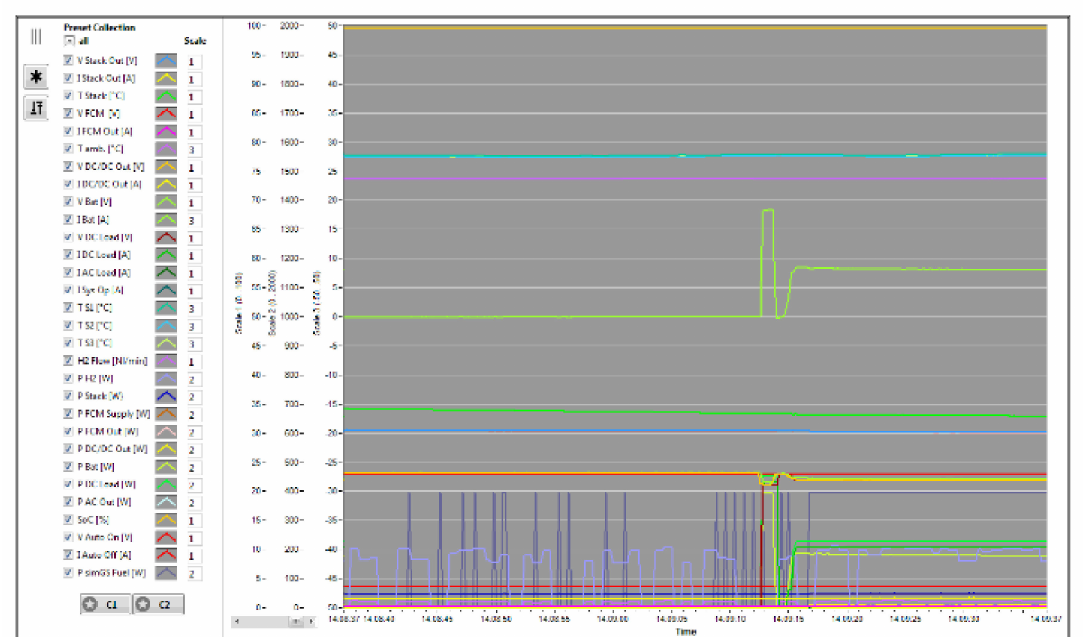
Figure 12. Data acquisition